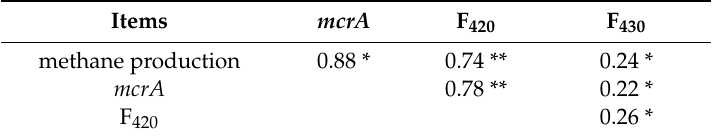
Table 4. Correlations between CH 4 production, mcr A gene expression, coenzyme F 420 content, and coenzyme F 430 content, regardless of the type of nitrocompound added.